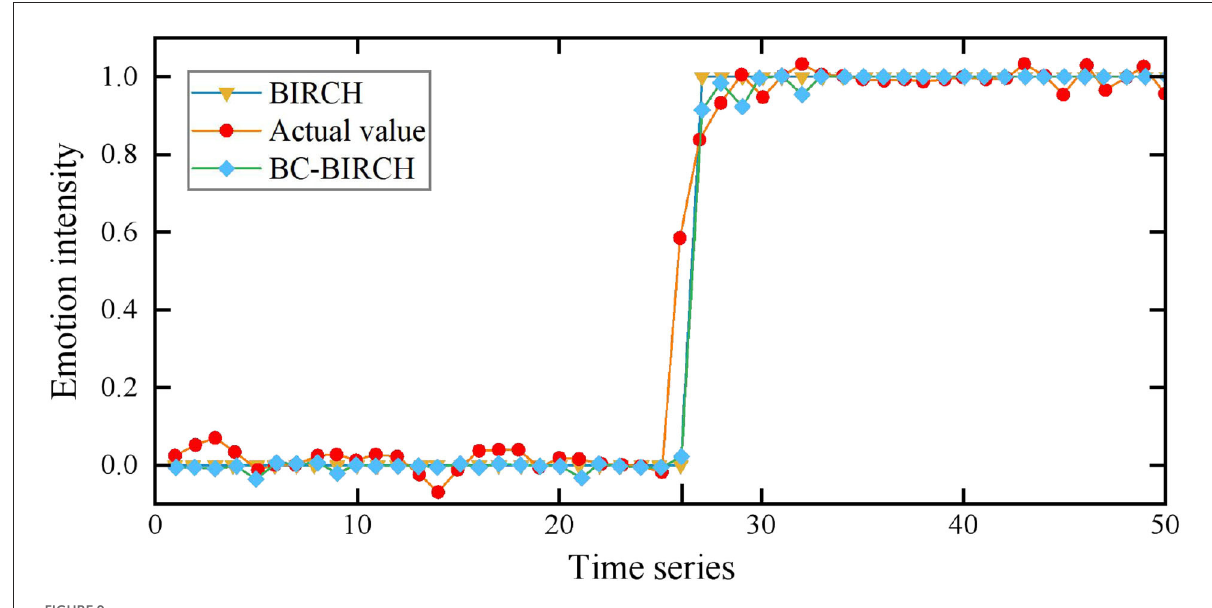
FIGURE9 The evolution results of